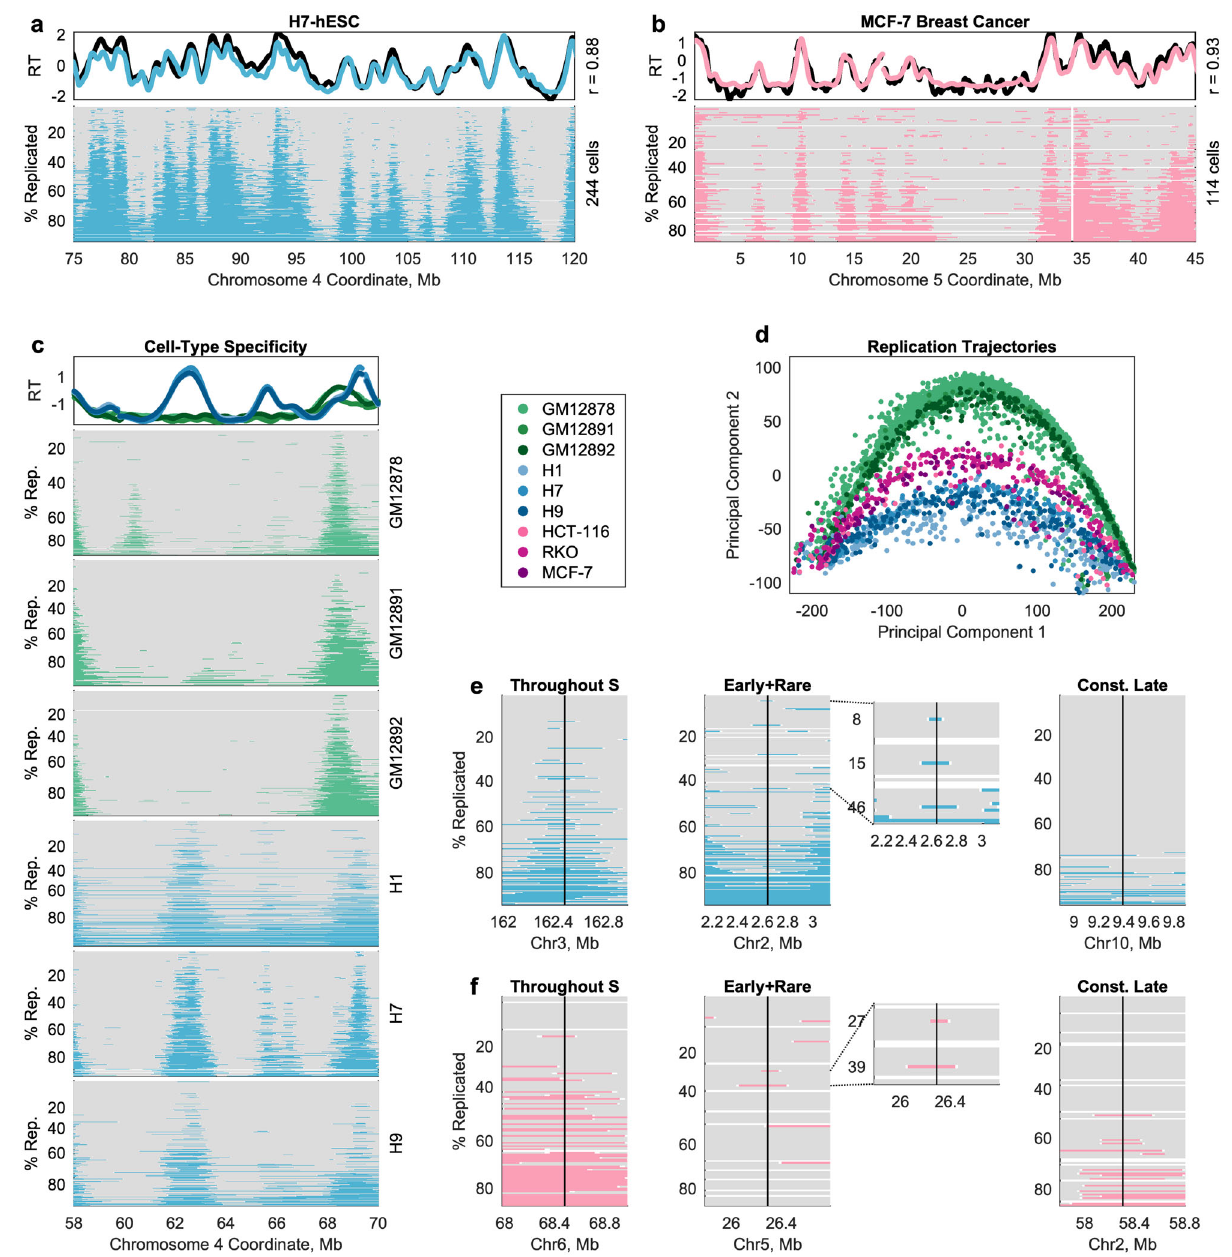
Fig. 6 Comprehensive measurement of single-cell replication timing across cell types. a , b As in Fig. 2a, for the embryonic stem cell line H7 ( a ) and for the breast cancer cell line MCF-7 ( b ). c Replication-timing variation between cell types is observed at the single-cell level. Top panel : bulk-sequencing consensus replication-timing pro fi les for LCL (green) and hESC (blue). Lower panels : single-cell data reveal that the bulk-sequencing peaks at ~62 Mb and ~65.5 Mb re fl ect the presence of hESC-speci fi c initiation sites. d Single cells follow cell-type-speci fi c trajectories of S-phase progression, as determined by principal component analysis (PCA). PCA was performed on replication states in all genomic windows across autosomes. PC1 corresponds to the % of the genome replicated ( r = 0.99), with negative values of PC1 re fl ecting early S phase and positive values re fl ecting late S phase. Cell types segregate along PC2. Each dot represents a single cell. e , f All three categories of IRs with late aggregate replication timing described in Fig. 5 were also observed in H7 ( e ) and MCF-7 ( f